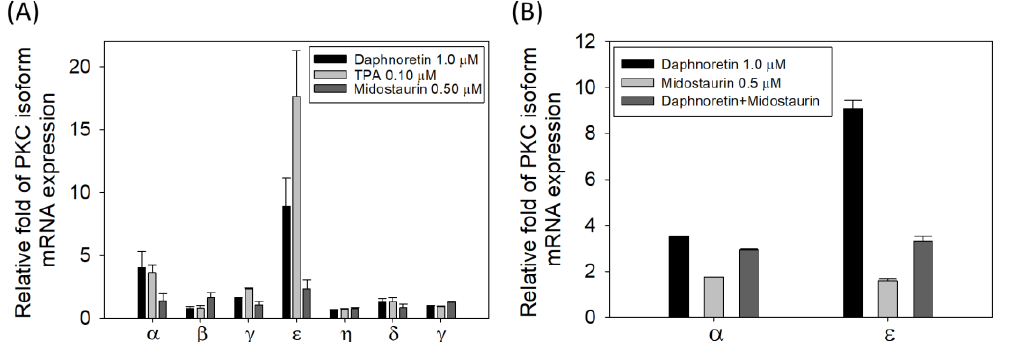
Figure 6. Relative mRNA expression of ( A ) different PKC isozymes with different treatments, ( B ) PKCα/PKCε with daphnoretin and midostaurin combined treatment. The mRNA expression was quantified by reverse transcription and qPCR using the Δct method. The mRNA levels of PKC were measured and normalized to the levels of the GAPDH control. Data represent the means SDs of three independent measurements.